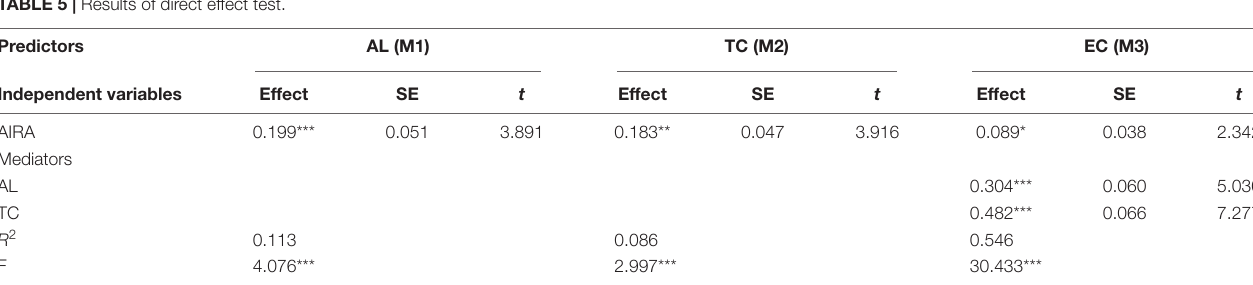
TABLE 5 | Results of direct effect